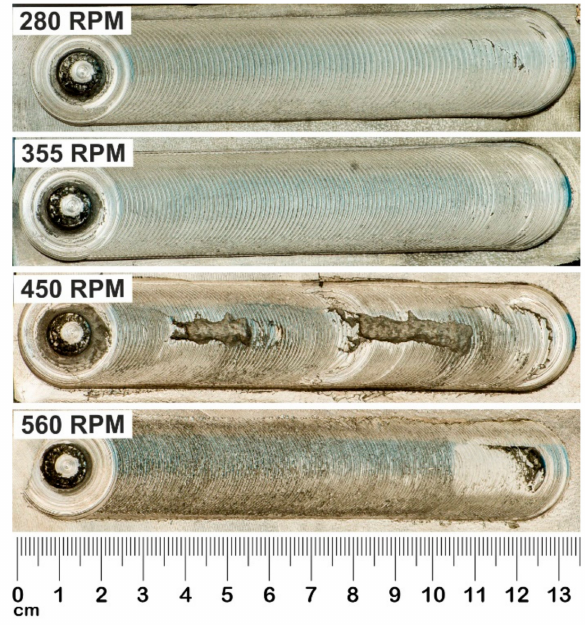
Figure 2. Photo of samples after FSP modification